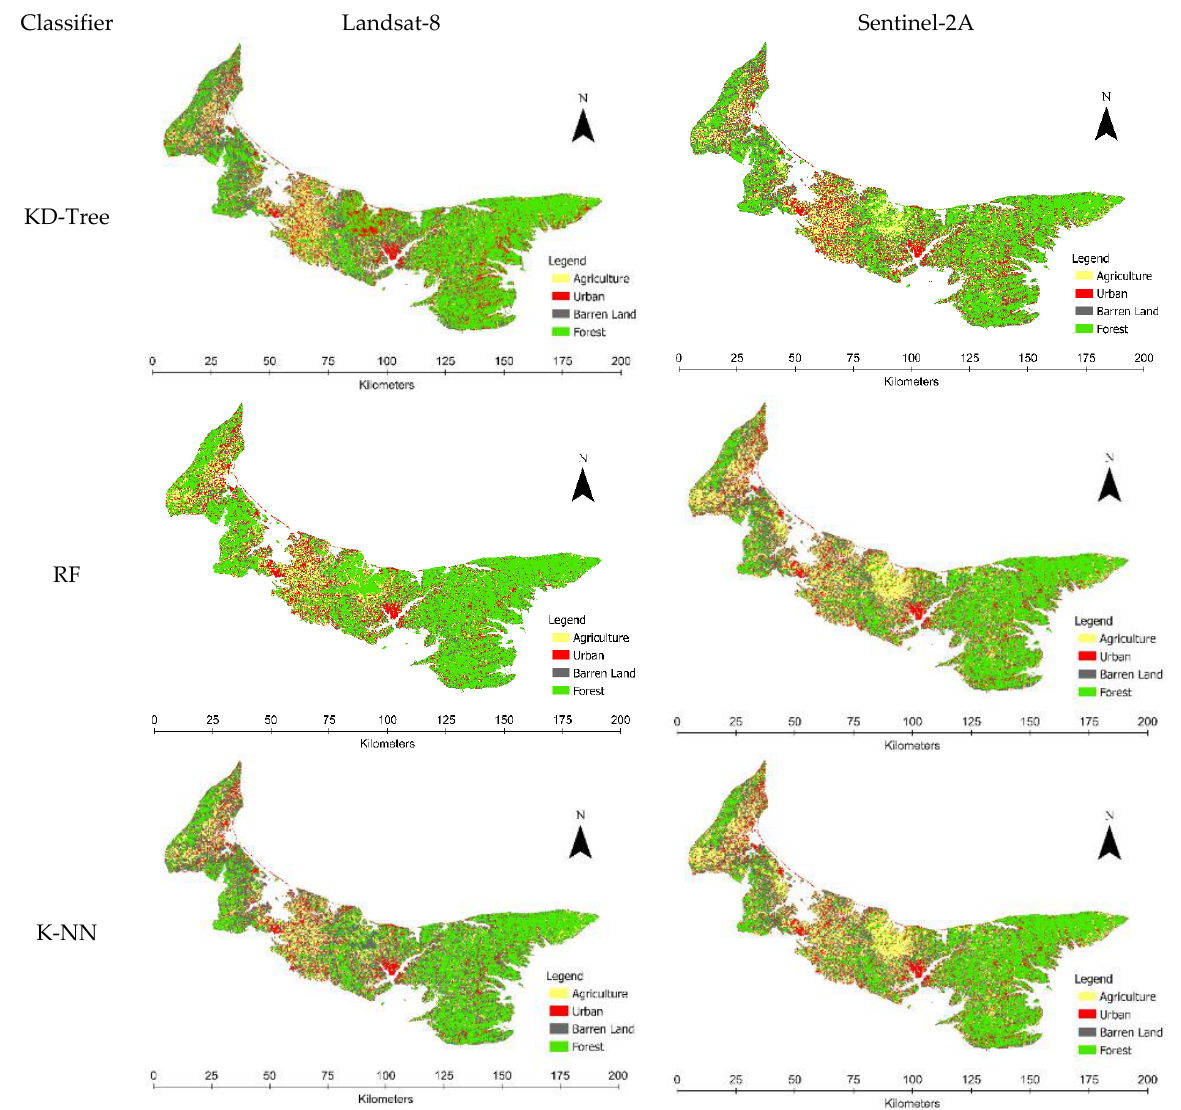
Figure 6. Remote sensing indices based LULC map prepared based on two satellites’ data. Land allocation was divided into four classes including agriculture, urban, forest and barren land. From the Landsat-8 imagery, the KD-Tree classifier detected the true positives for the Table 4. User and producer accuracies for LULC types used in this agriculture class, e.g., 45 out of 50 with a user accuracy of 90% and a producer accuracy of 79% (Figure 7A and Table 4). For Sentinel-2A imagery, the highest true positives were classified by the K-NN algorithm, e.g., 47 out of 50 for the agriculture class. The RF and K-NN in Landsat-8 and KD-Tree and RF in Sentinel-2A recorded true positives for agri- culture classes ranging within 38 – 45 out of 50 (Figure 7A,D). Interestingly, the highest and